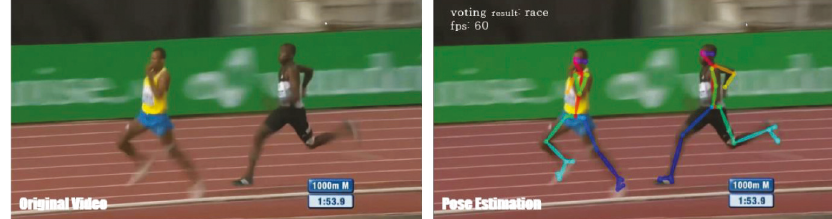
Figure 5: Results of human pose estimation based on AAEN for track and field events in the racing category.